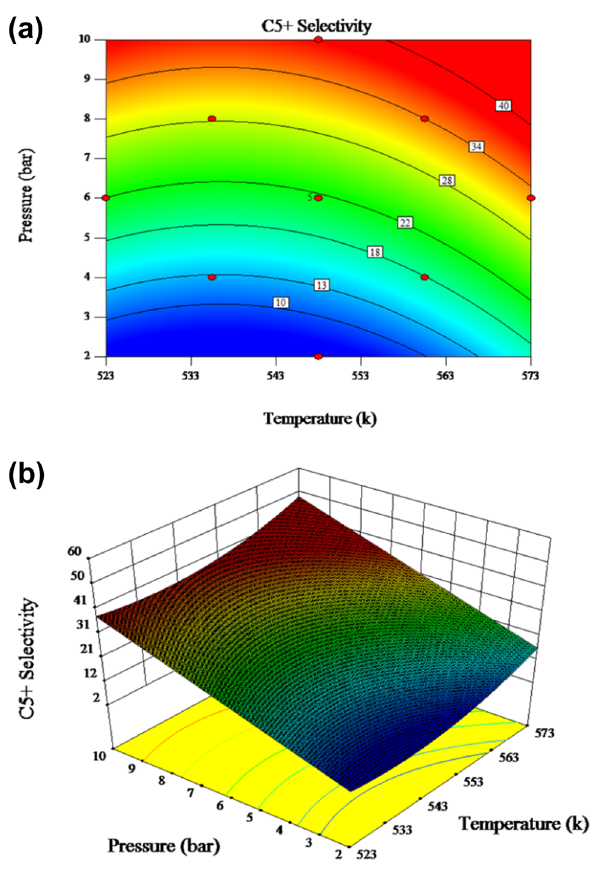
Fig. 6 Contour ( a ) and 3D surface ( b ) plots for C þ